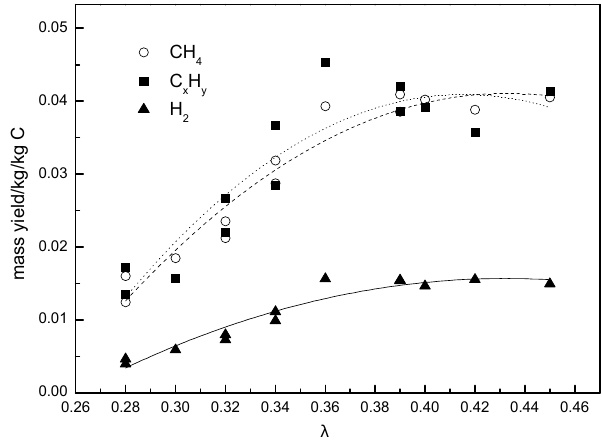
Figure 8. CH 4 , C x H y and H 2 mass yield.